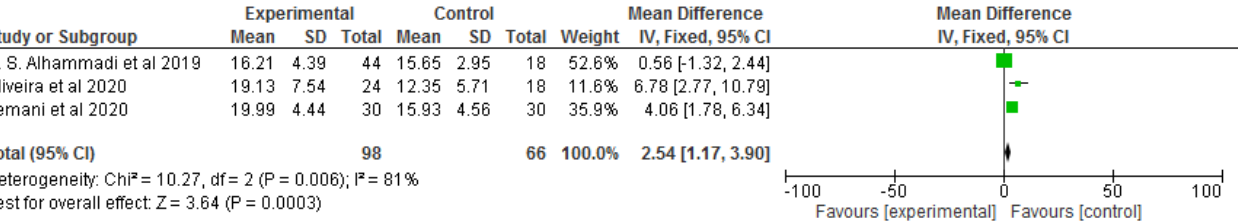
Figure 8. Forest plot for functional appliance between experiment and control.